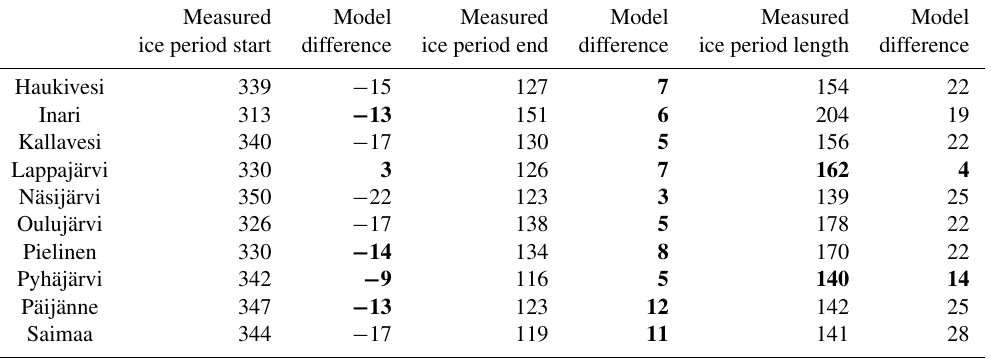
Table A1. Measured ice period start and end days (as the day of the year) and the length of the ice period in days. The differences to modeled values are also shown (model–measurements; i.e., when the values are negative, the model is too early in its prediction and when the values are positive, the model is late in its prediction). If the difference between measured and modeled ice period start, end or length is less than 2 weeks, the values are boldfaced. The values have been averaged for the time period